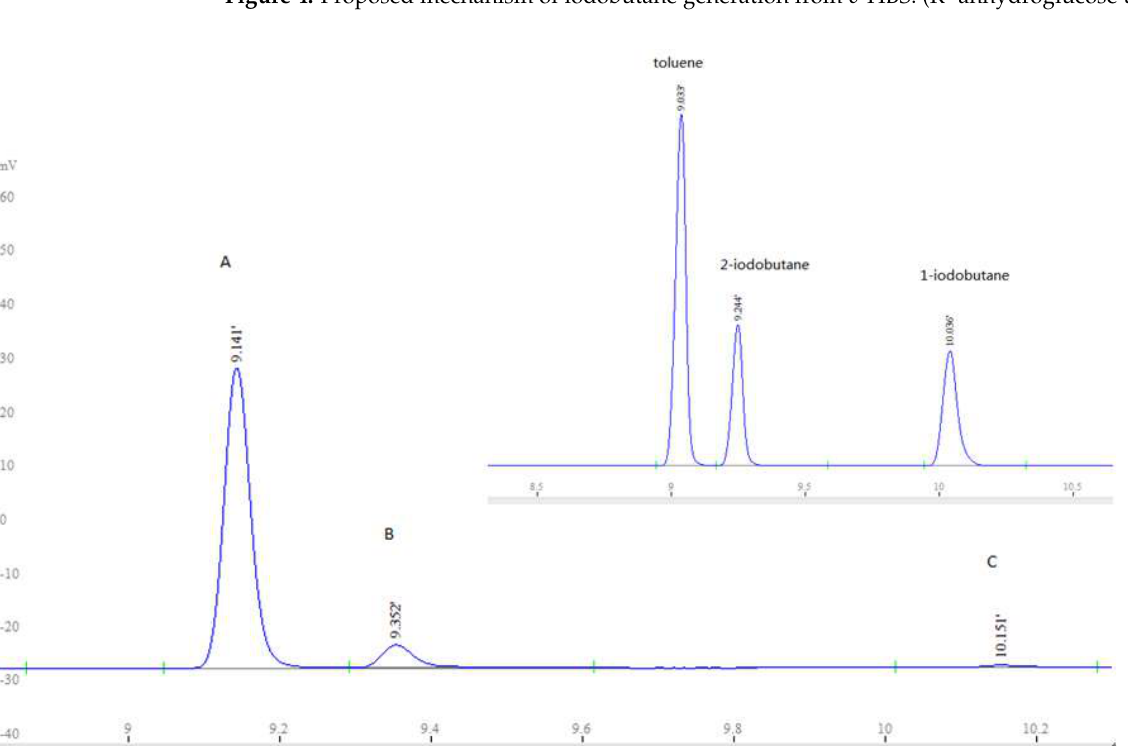
Figure 5. Chromatogram of extracts of the upper (o-xylene) layer of the reaction solution: ( A ) toluene; ( B ) 2-iodobutane; ( C ) 1-iodobutane.